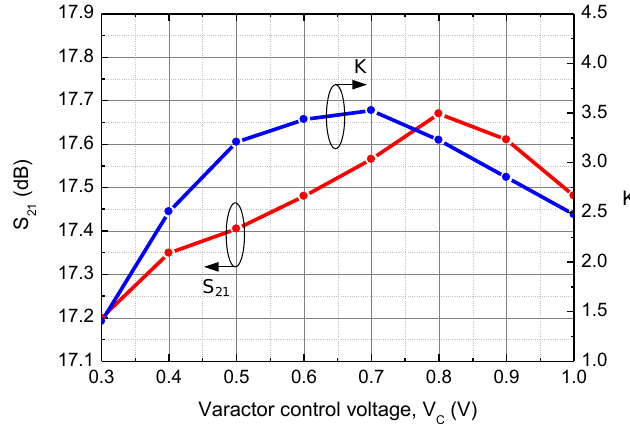
Figure 13. Measured gain (S 21 ) and stability factor (K) versus varactor control voltage at 79 GHz.